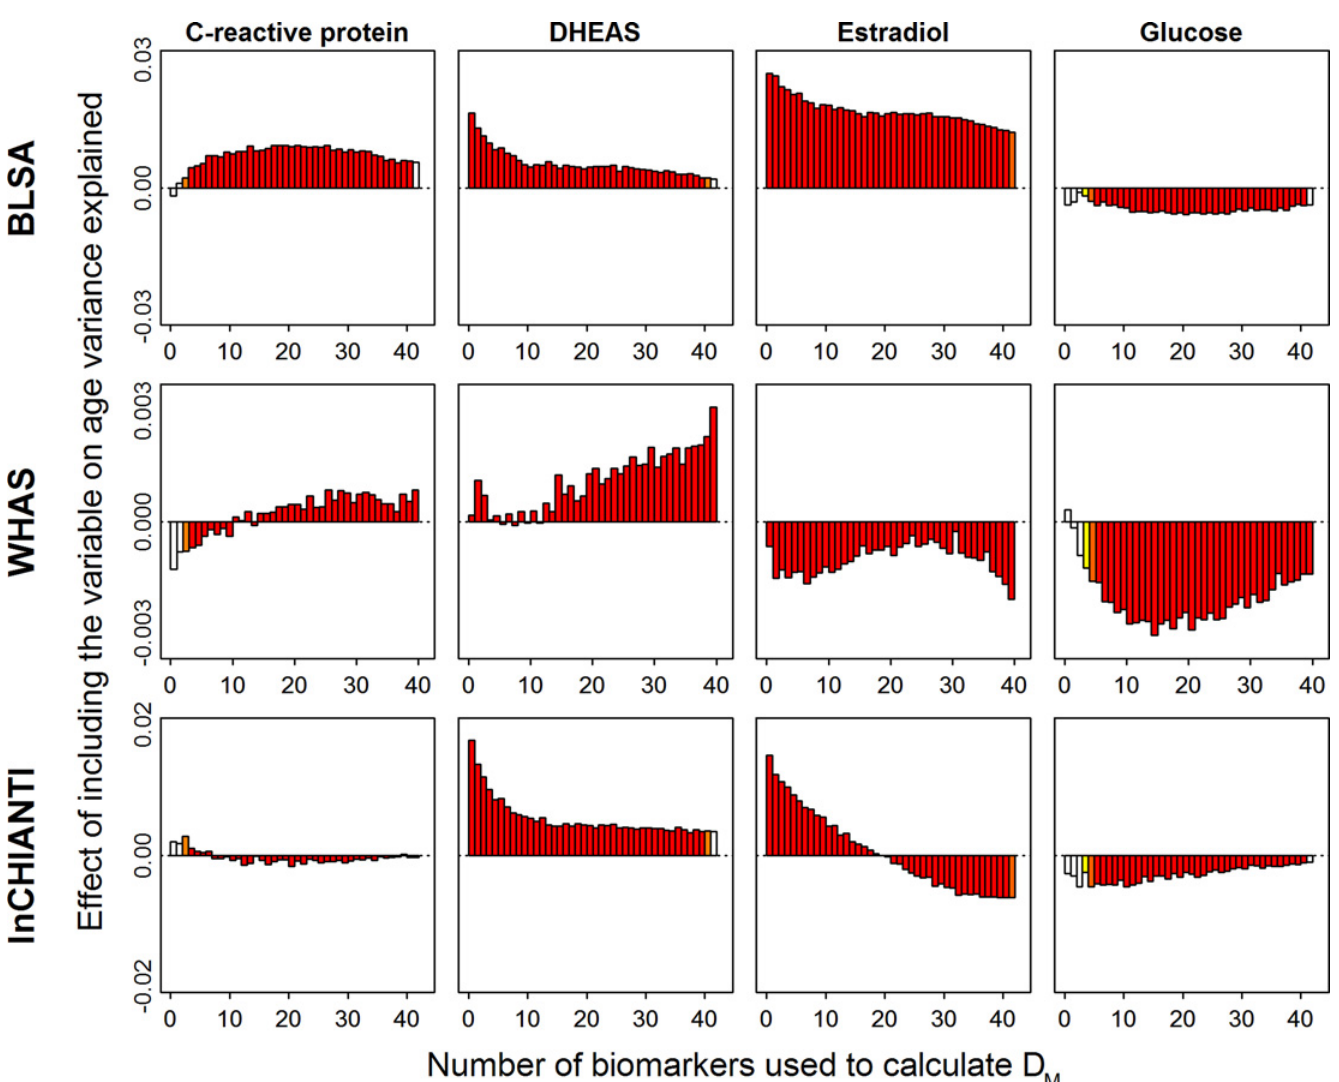
Fig 5. Contribution of selected individual biomarkers to change in variance in age explained by D M . The X-axis represents the number of biomarkers per group ( N bm ), while the Y-axis reports the change in how much variance in age is predicted by D M with the inclusion of the given biomarker, based on a meta-regression of all the R-squareds calculated for individual quadratic regressions of age and D M . Colors indicate the magnitude of p -values, with darker red being more significant and white not significant. Graphs for all biomarkers can be found in S12 – S15